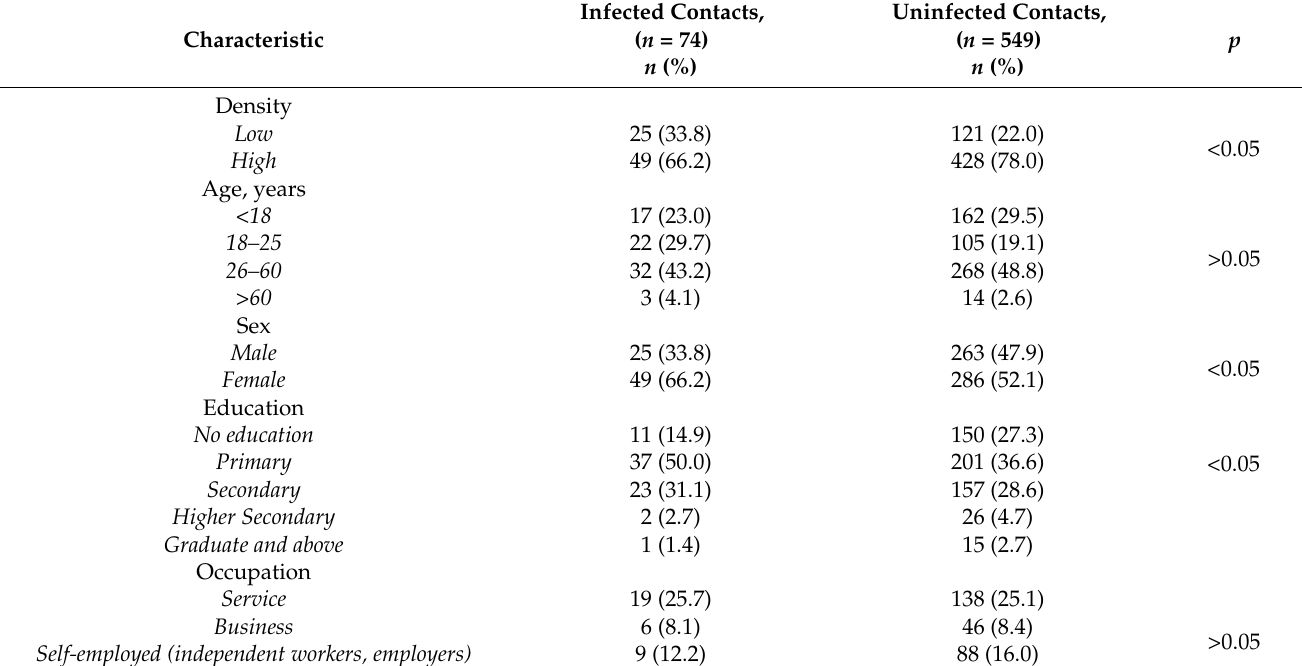
Table 2. Distribution and comparison of demographic characteristics among infected and non- infected